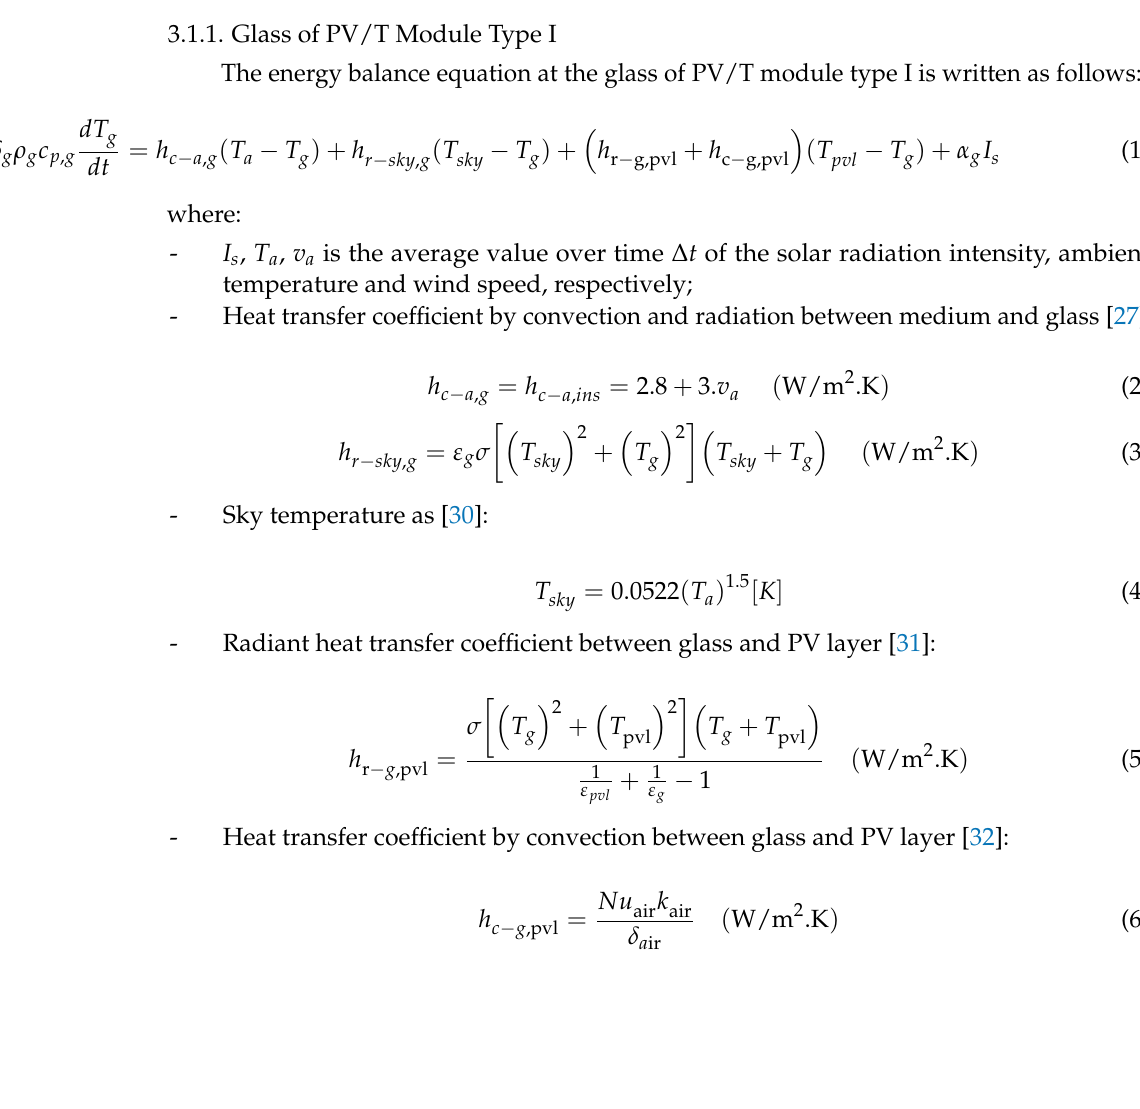
Figure 5. Heat flow between components in type I ( a ) and type II ( b ) PV/T modules.